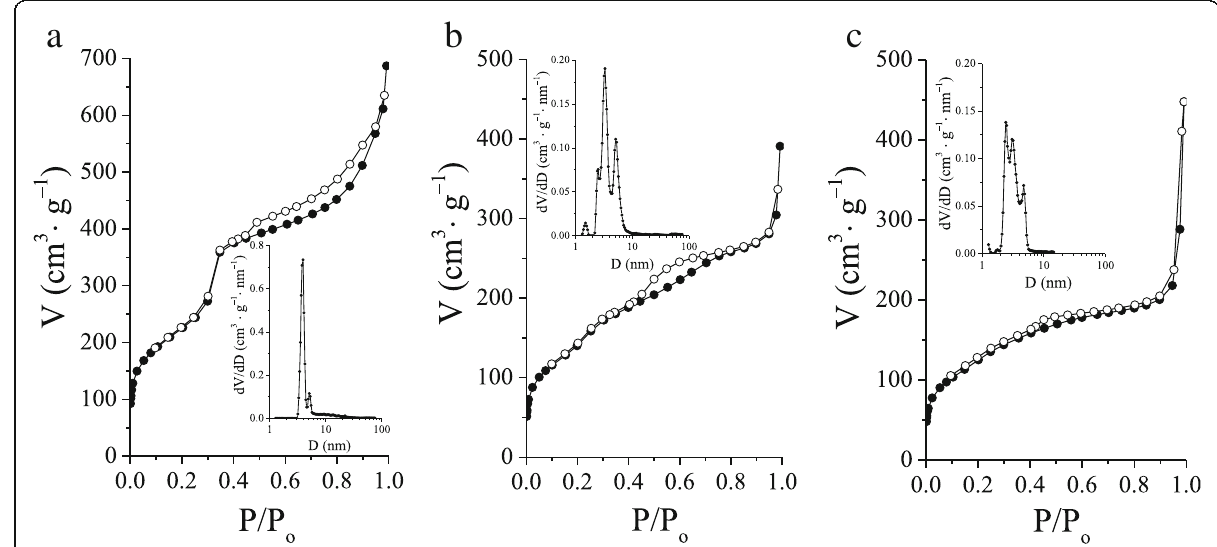
Fig. 4 Nitrogen adsorption – desorption isotherms and NLDFT pore diameter of β -CD-APTES-MCM-41 ( a ), β -CD-APTES 3 -MCM-41 ( b ), and β -CD-APTES Solid symbols denoted adsorption, and open symbols denoted 5 -MCM-41 ( c ) silicas.